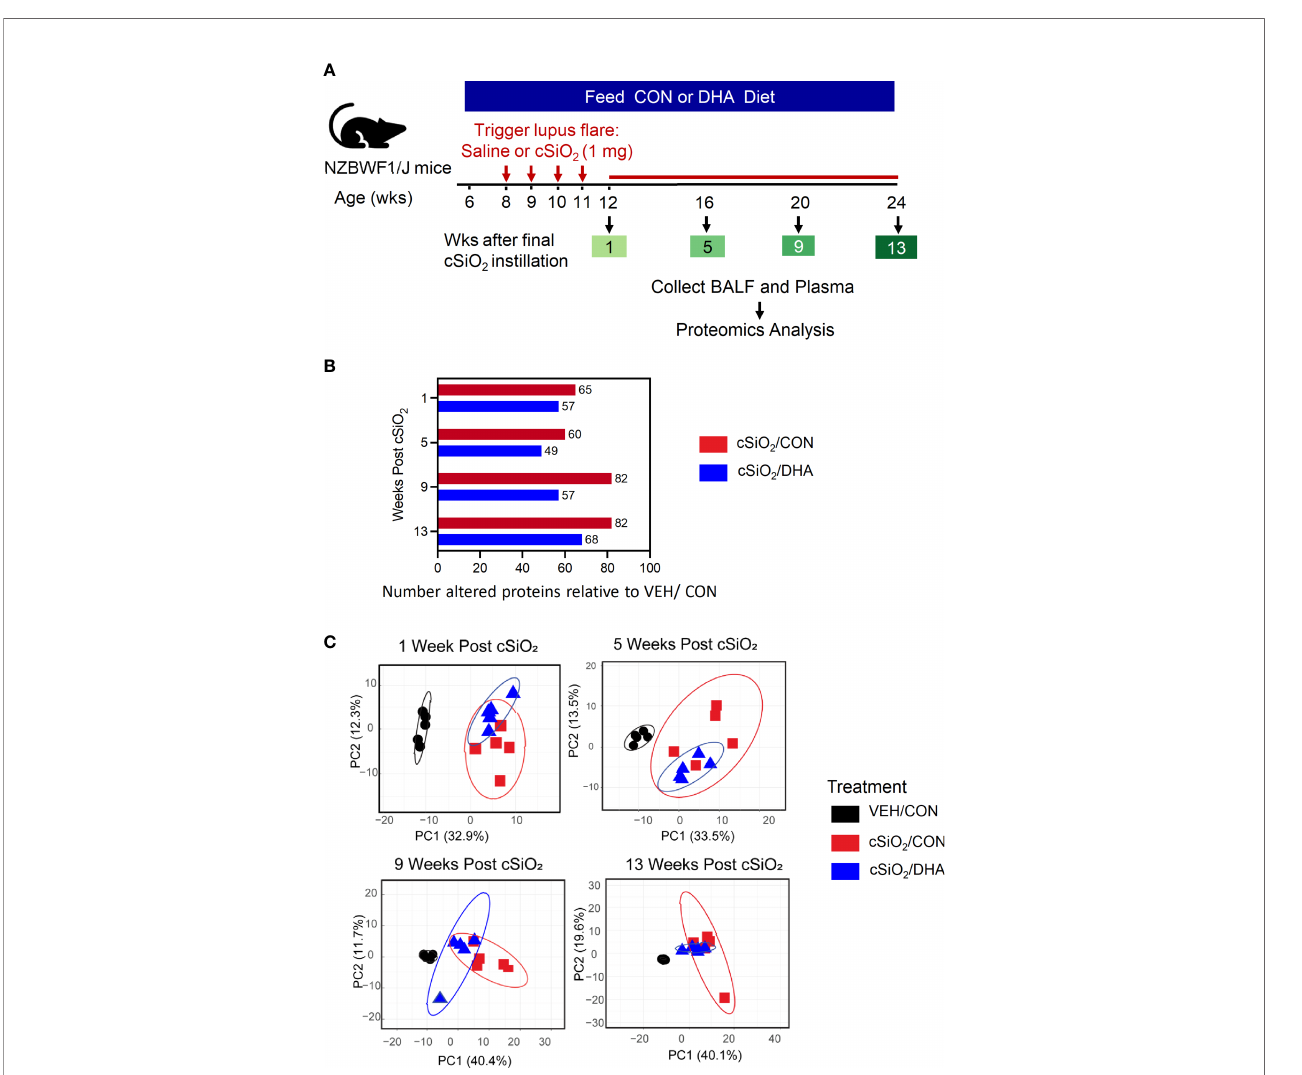
FIGURE 1 | Experimental design and in fl ammatory protein analysis of BALF. (A) Feeding of control (CON) or DHA diets was initiated in 6 wk-old female NZBWF1 mice. Two wk later, groups were intranasally instilled with 1mg cSiO 2 or vehicle weekly for 4wk. Animals were sacri fi ced at 12, 16, 20, or 24wk of age, corresponding to 1, 5, 9, or 13wk post fi nal instillation (PI), respectively. Plasma and BALF were collected and analyzed for in fl ammatory proteins by high throughput multiplexed array. (B) cSiO 2 induced fewer proteins in BALF of mice fed DHA diet over time than those fed control diet. (C) PCA of differentially expressed protein in BALF of VEH/CON,